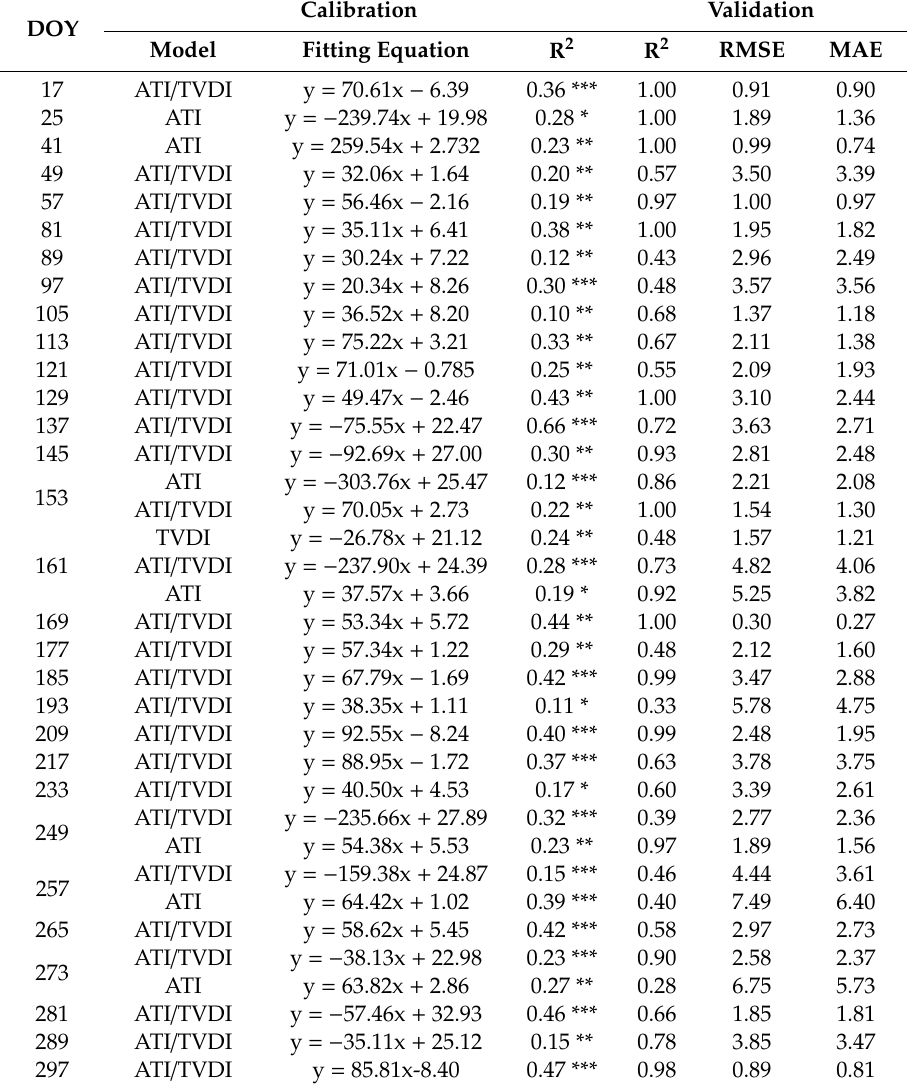
Table A3. Data description and accuracy of these models for RSM